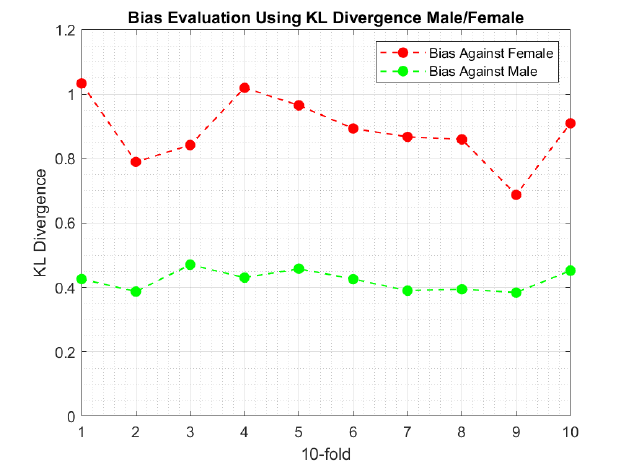
Figure 4. The KL divergence of male and female shows the bias against females.